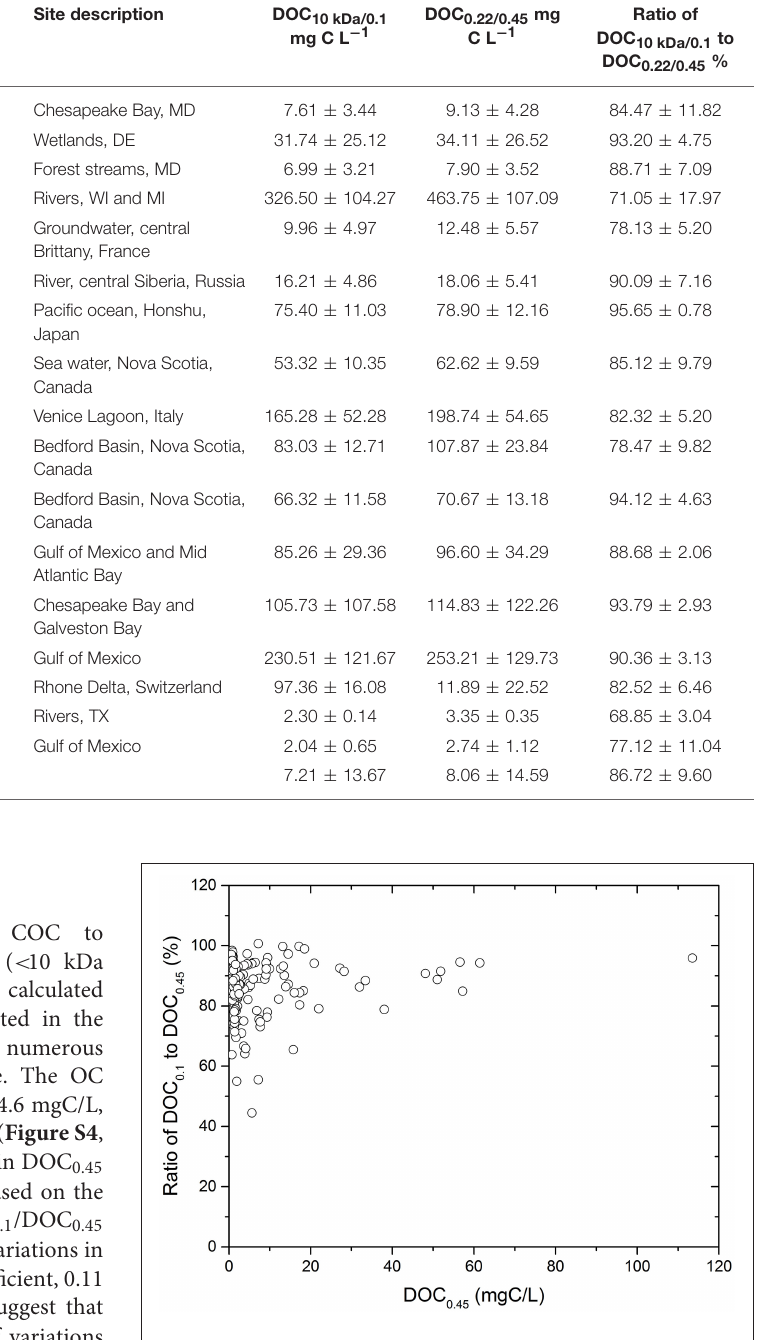
FIGURE 3 | Relationship of ratio of DOC 0.1 to DOC 0.45 with DOC 0.45 of samples from this study and